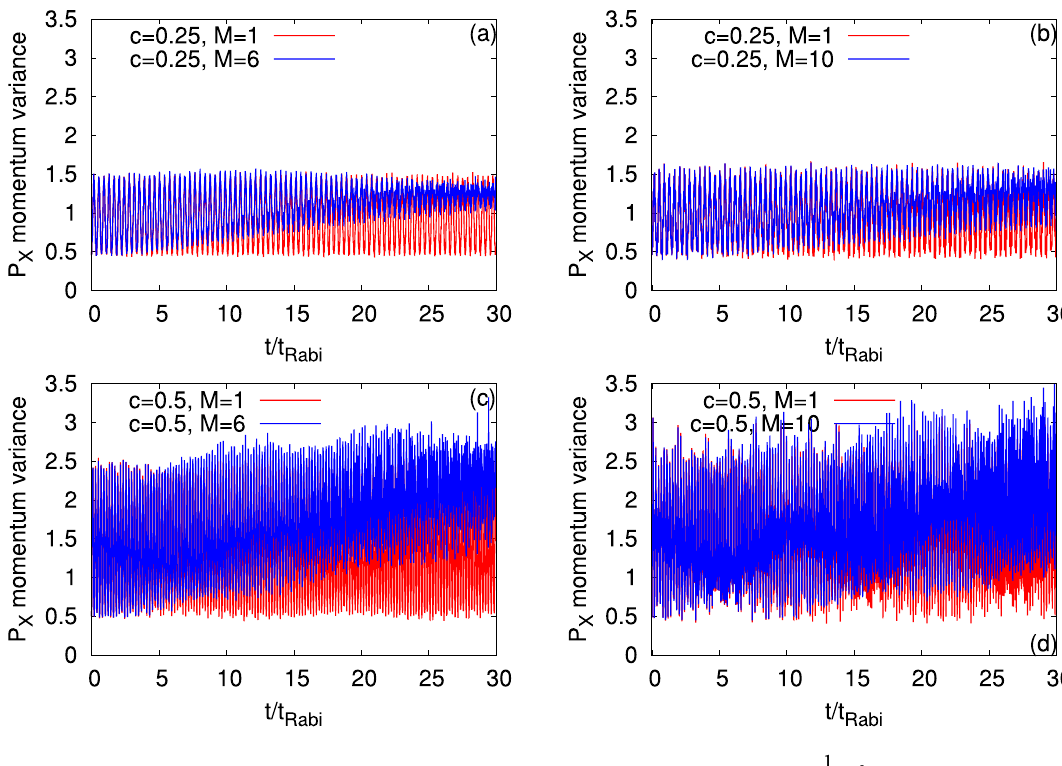
Figure 6. Time-dependent momentum variance per particle along the x -direction, longitudinally-asymmetric 2D double-well potential for (cid:31) G (left column) and (cid:31) Y (right column) of N bosons with the interaction parameter � tunneling with asymmetry parameter, c many-body dynamics are computed with M orbitals for (cid:31) Y . We show here dimensionless quantities. Color codes are explained in each